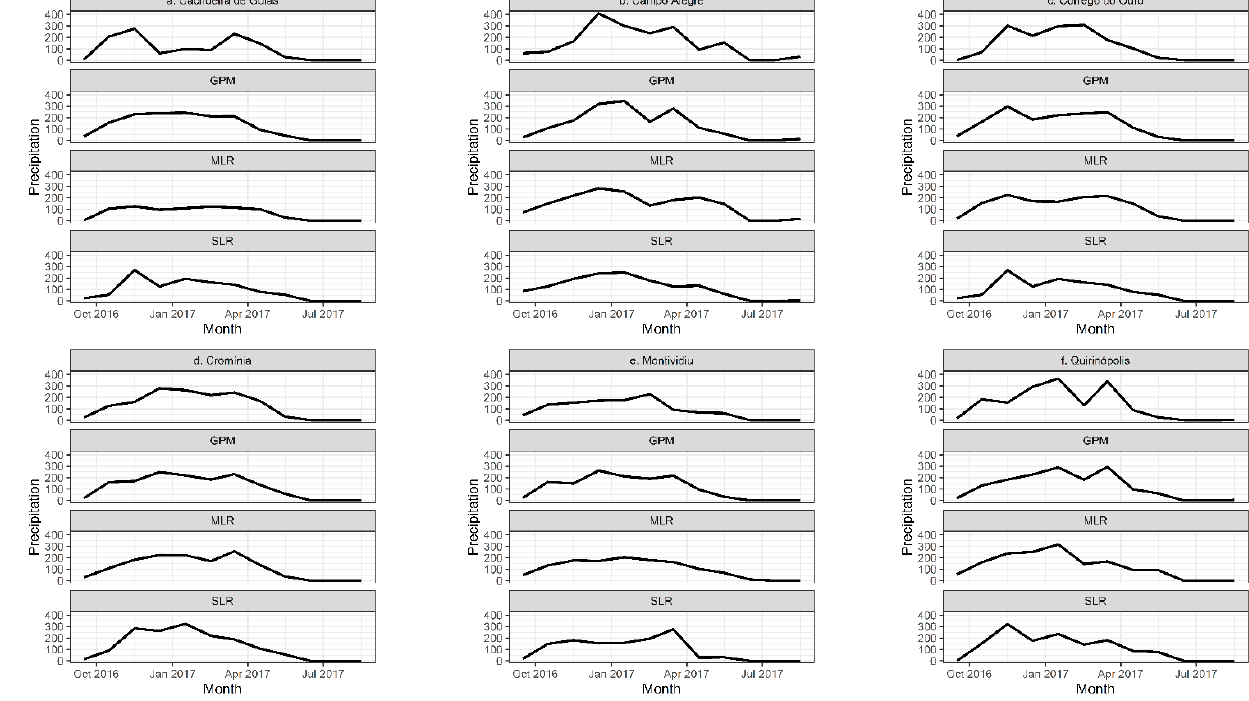
Figure 10. Monthly precipitation at the test stations: ( a ) Cachoeira de Goiás, ( b ) Campo Alegre, ( c ) Córrego do Ouro, ( d ) Cromínia, ( e ) Montividiu, and ( f ) Quirinópolis in the water year of 2016–2017.